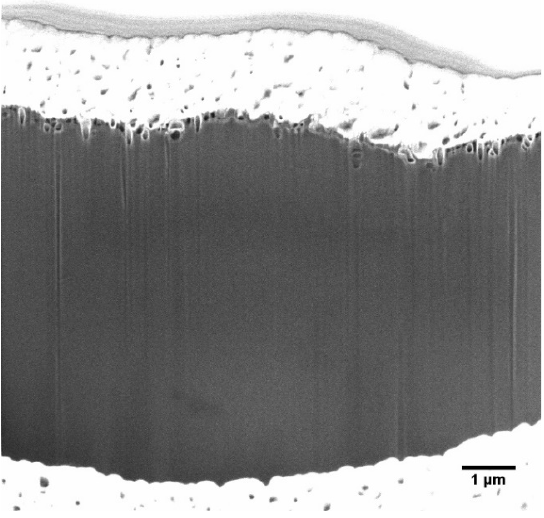
Figure 6. 10 × 10 µm 2 FIB/SEM image of a diagonal corner cross-section of CNF-4. Figure 6. 10 × 10 µ m 2 FIB/SEM image of a diagonal corner cross-section of CNF-4. The porosity of the membranes was assessed by nitrogen adsorption and desorption. The porosity of the membranes was assessed by nitrogen adsorption and